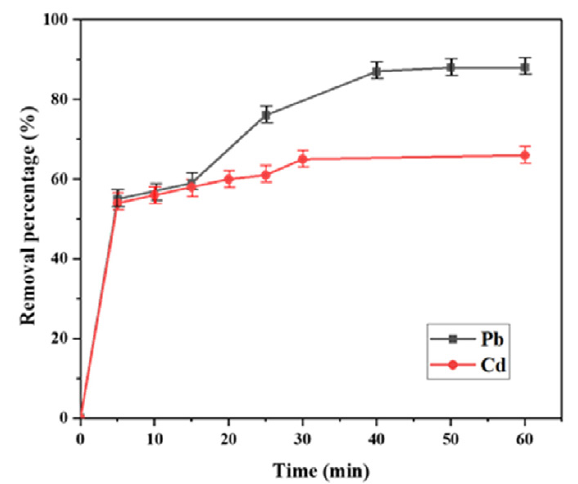
Fig. 7. Effect of contact time on the removal percentage (±0.4) of Cd(II) and Pb(II) by pectin/ γ -Fe